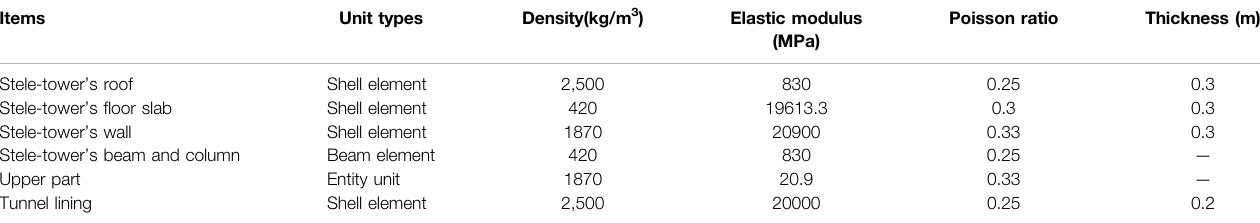
TABLE 1 | Computational parameters of the